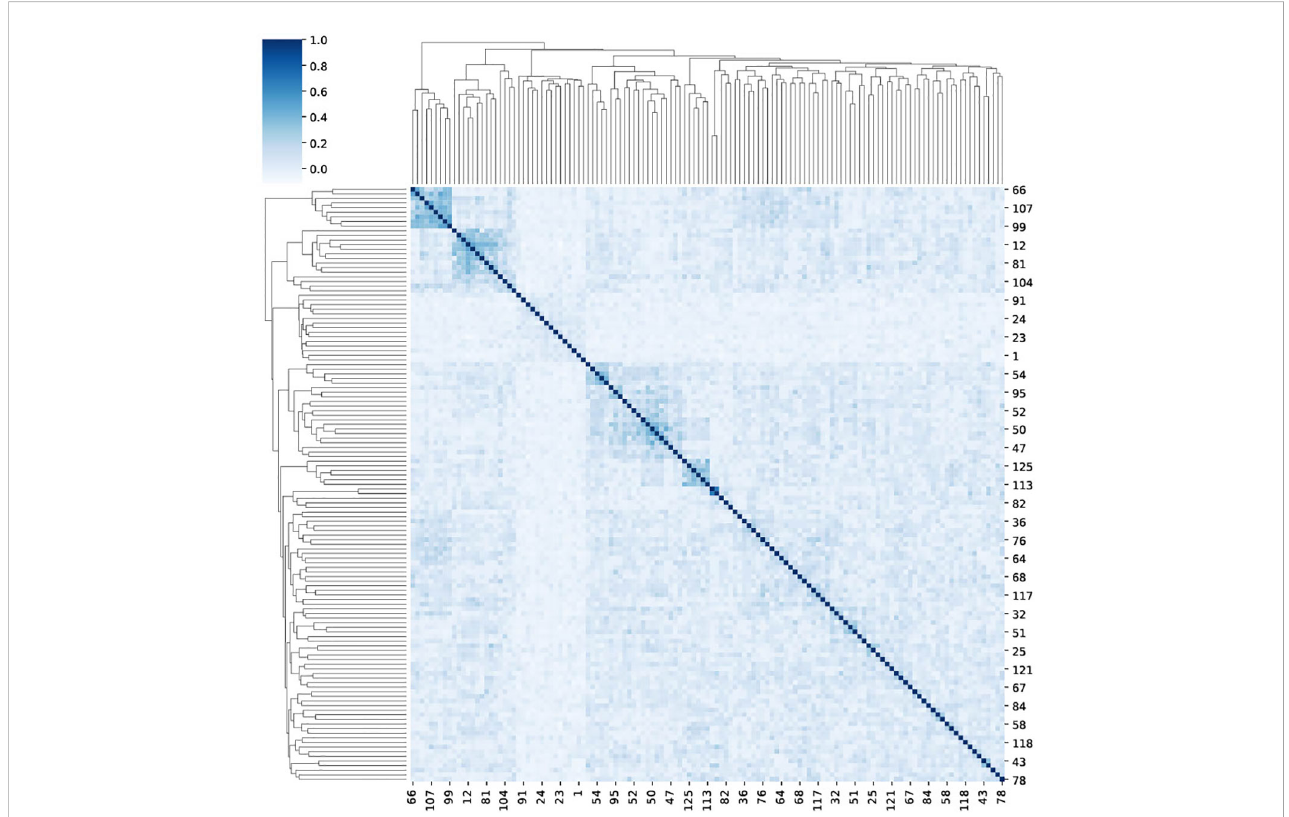
FIGURE 5 A clustermap of the Spearman correlation between 125 reactive TCRs. For each reactive TCR, we extracted from the ECD (4), and we assigned a one-hot vector that represents the appearance of the TCR in different repertoires in the data. Then, for each TCR pairing, we calculated the Spearman correlation between their one-hot